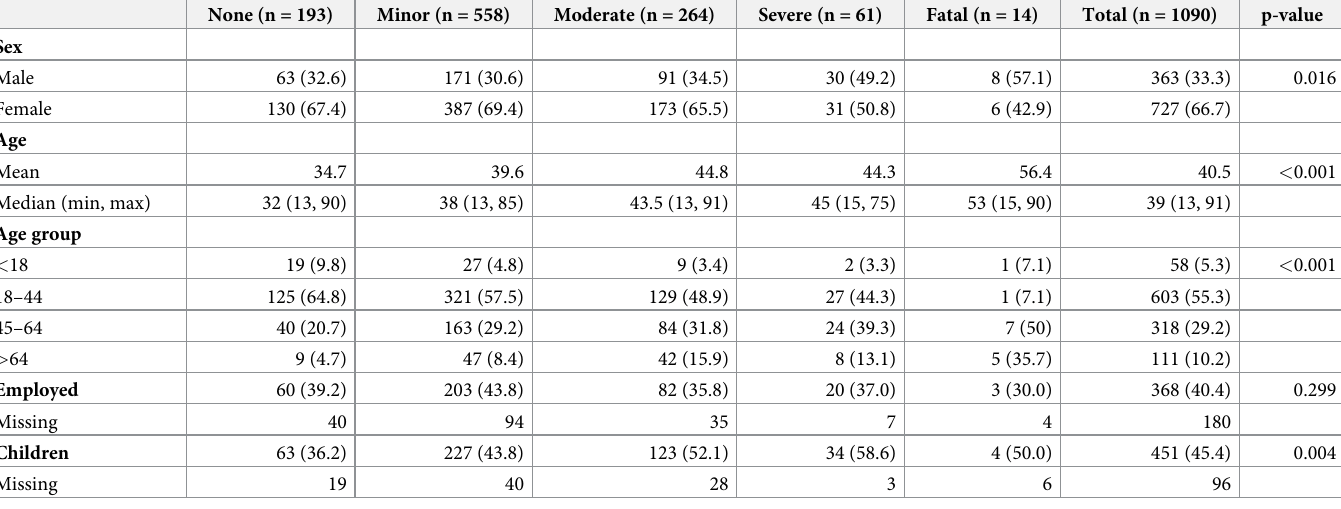
Relationship between socio-demographic parameters and severity of poisoning Table 1 shows socio-demographic parameters grouped by the severity of the poisoning (the results of pairwise comparisons are shown in S4 Table). There were significant differences between the degrees of severity in terms of gender, age groups, average age, and parenthood. In particular, the male gender dominated in case of lethal poisonings whereas in the PSS: none, minor, and moderate cases, women predominated. Only in cases of severe poisoning Table 1. Relationship between sociodemographic parameters and severity of